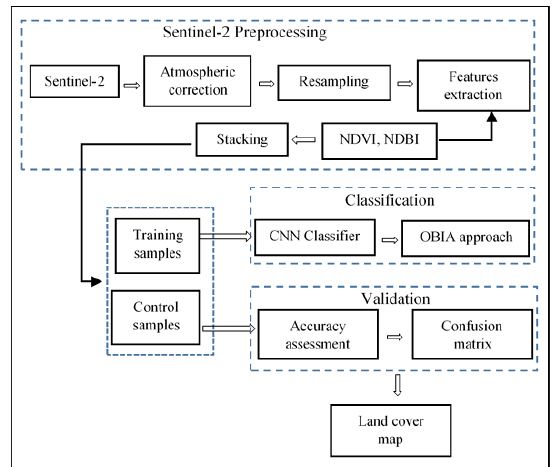
Figure 2 : Flowchart of the proposed